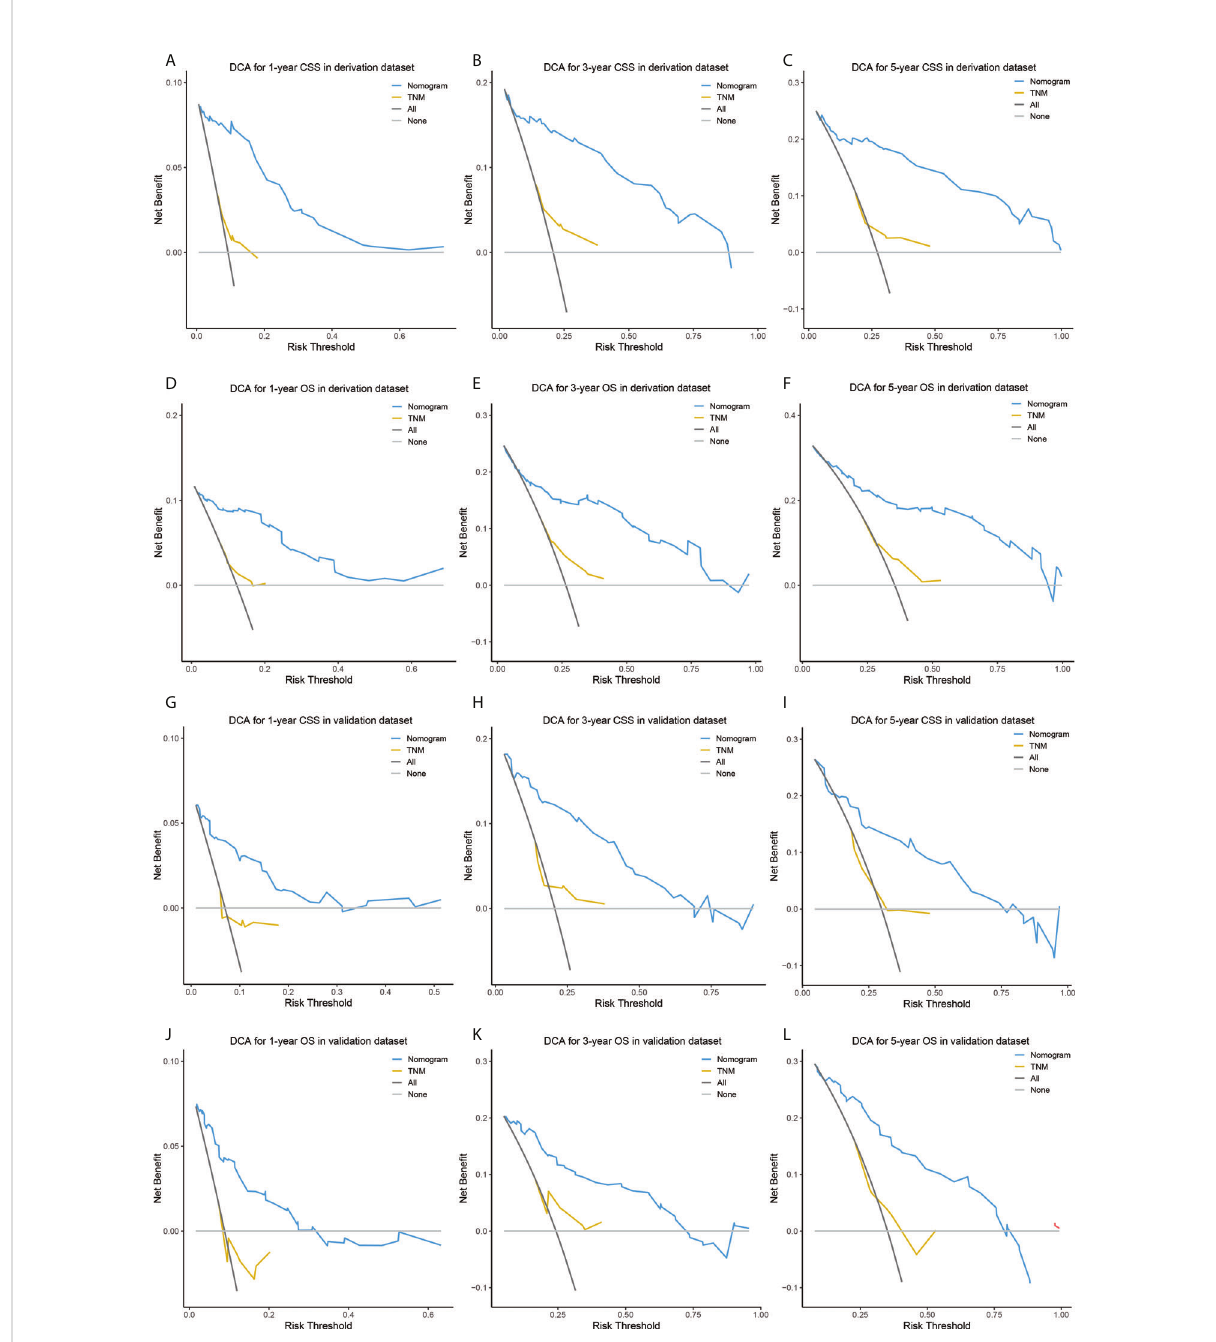
FIGURE 5 DCA of the nomograms and TNM staging system for predicting 1-, 3-, 5-year CSS in the derivation dataset (A – C) and external validation dataset (D – F) , and 1-, 3-, 5-year OS in the derivation dataset (G – I) and external validation dataset (J – L) . DCA, decision curve analysis; CSS, lung cancer- speci fi c survival; OS, overall